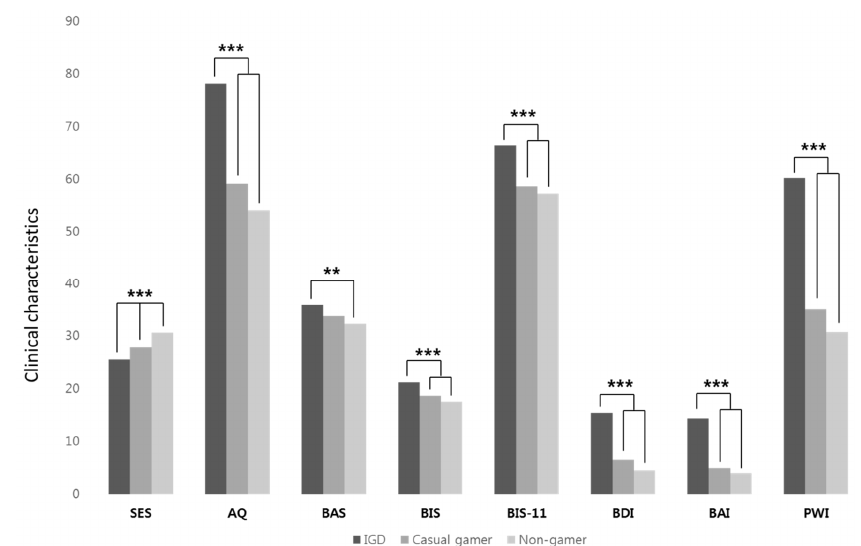
Figure 1. Comparison of self-efficacy and clinical characteristics adjusted for sex; IGD = internet gaming disorder; SES = Self-Efficacy Scale; AQ = Aggression Questionnaire; BAS = Behavioral Activation System; BIS = Behavioral Inhibition System; BIS-11 = Barratt Impulsiveness Scale version-11; BDI = Beck Depression Inventory; BAI = Beck Anxiety Inventory; PWI = Psychosocial Well-being Index; ** p < 0.01, *** p < 0.001.